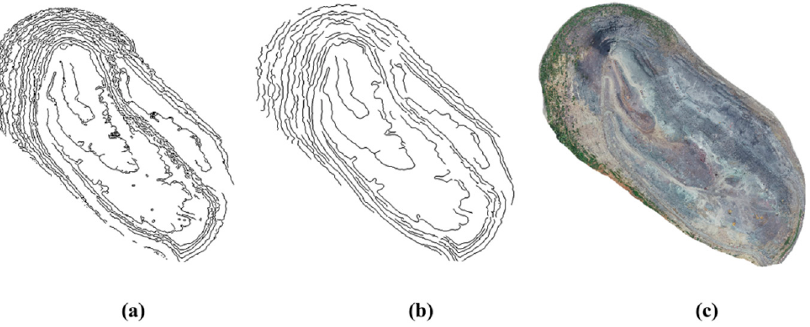
Figure 18. ( a ) Detection result of Canny algorithm; ( b ) detection result of EDEG-CS method; ( c ) real view of point cloud in the open-pit mine.